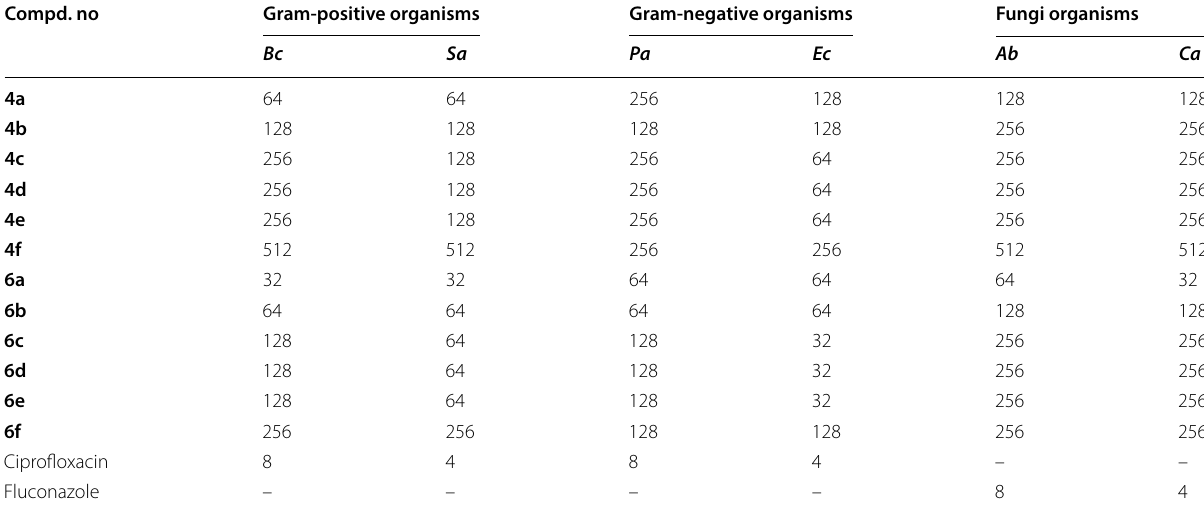
Table 1 Antimicrobial screening results of compounds 4a–f and 6a–f presented as MIC (μg/mL) Compd. no